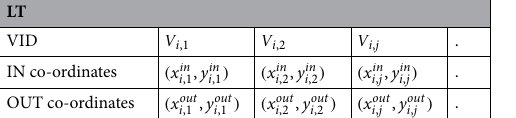
Table 4. Range for in-out coordinates.